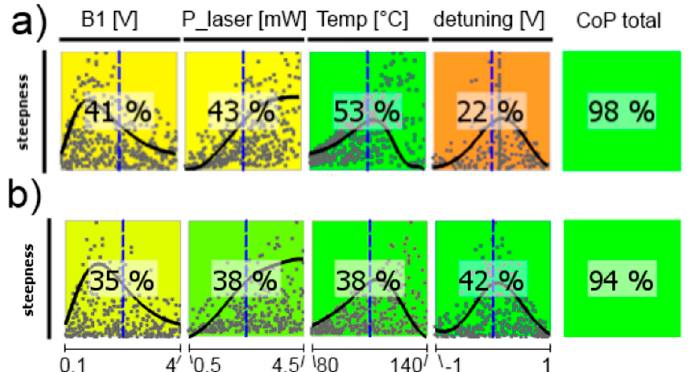
Figure 14. CoP matrix of the resonance depths for the medium-pressure magnetometer. Since the resonance depth is calculated as the difference between peak current and minus dc level, the values are negative. So, lower values means higher absorption. Approximation technique: isotropic kriging.